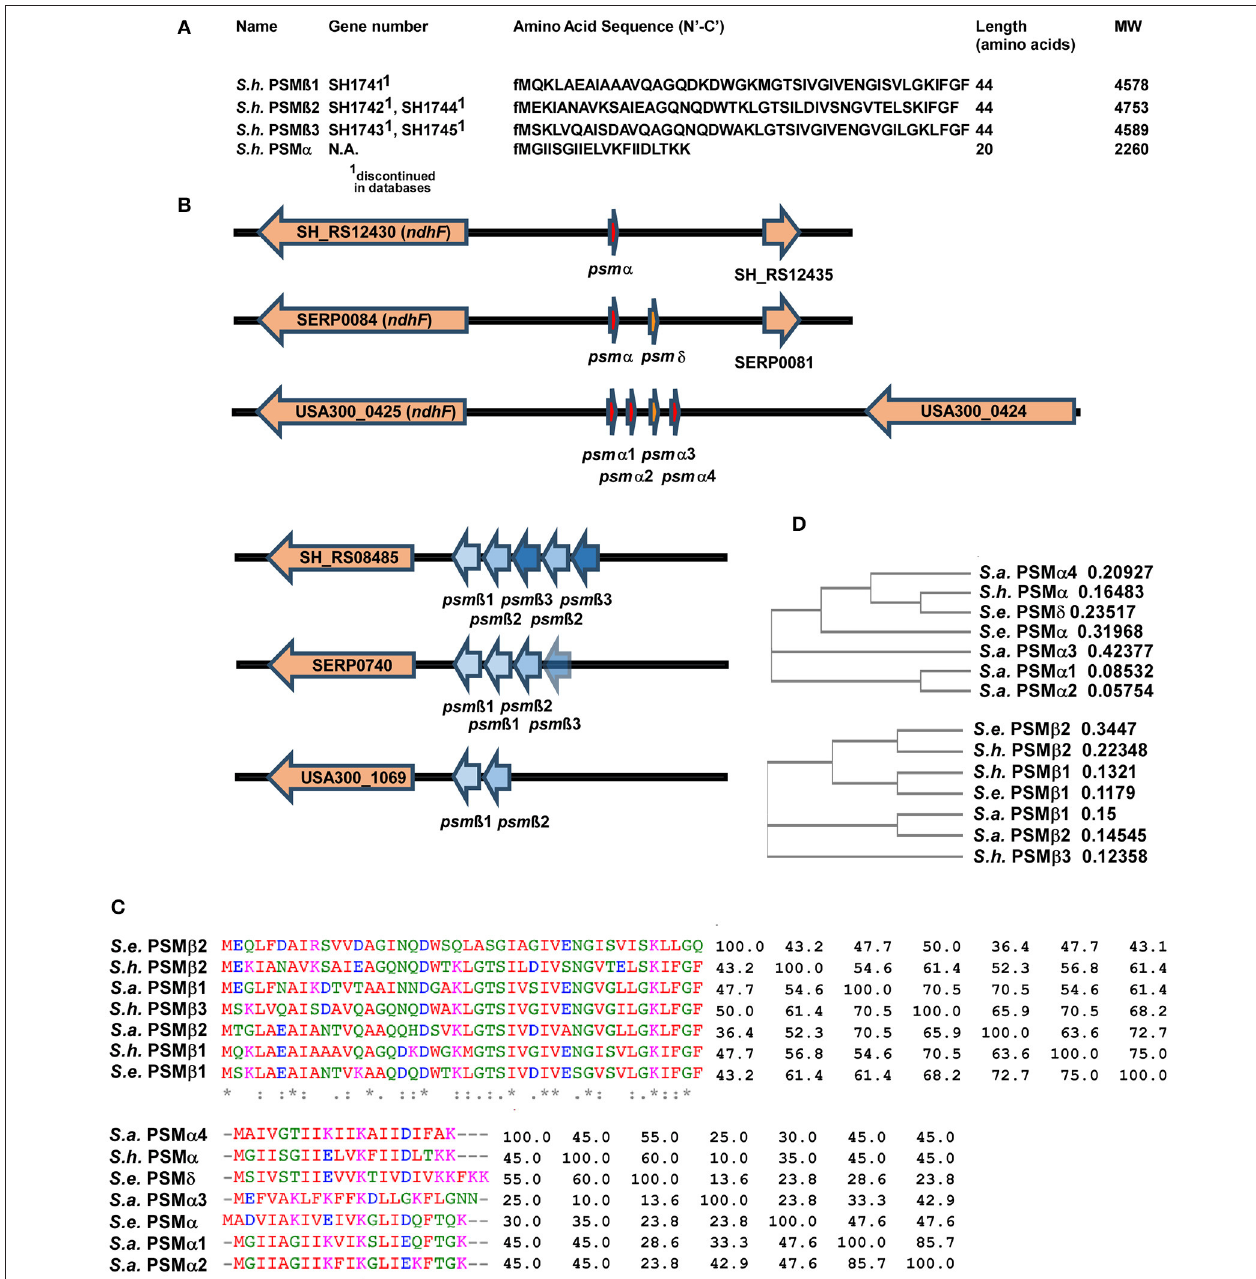
FIGURE 3 | Amino acid sequences and genes of S. haemolyticus PSMs and encoding loci in comparison with S. aureus and S. epidermidis. (A) Amino acid sequences of S. haemolyticus PSMs determined by N-terminal sequencing and/or comparison of molecular weights with annotated open reading frames in the S. haemolyticus genome. (B) Location of PSM-encoding genes in the genome of S. haemolyticus , in comparison with corresponding loci in S. aureus and S. epidermidis . Gene numbers for S. aureus and S. epidermidis are those from the USA300 FPR3757 or RP62A strain genomes, respectively. (C,D) Alignments and calculated phylogenetic trees of PSM α and PSM β peptides of S. haemolyticus , S. aureus, and S. epidermidis . Sequences were analyzed using the online tool Clustal Omega (http://www.ebi.ac.uk/Tools/msa/clustalo/). Next to the alignment in (C) , the pairwise similarity matrix is